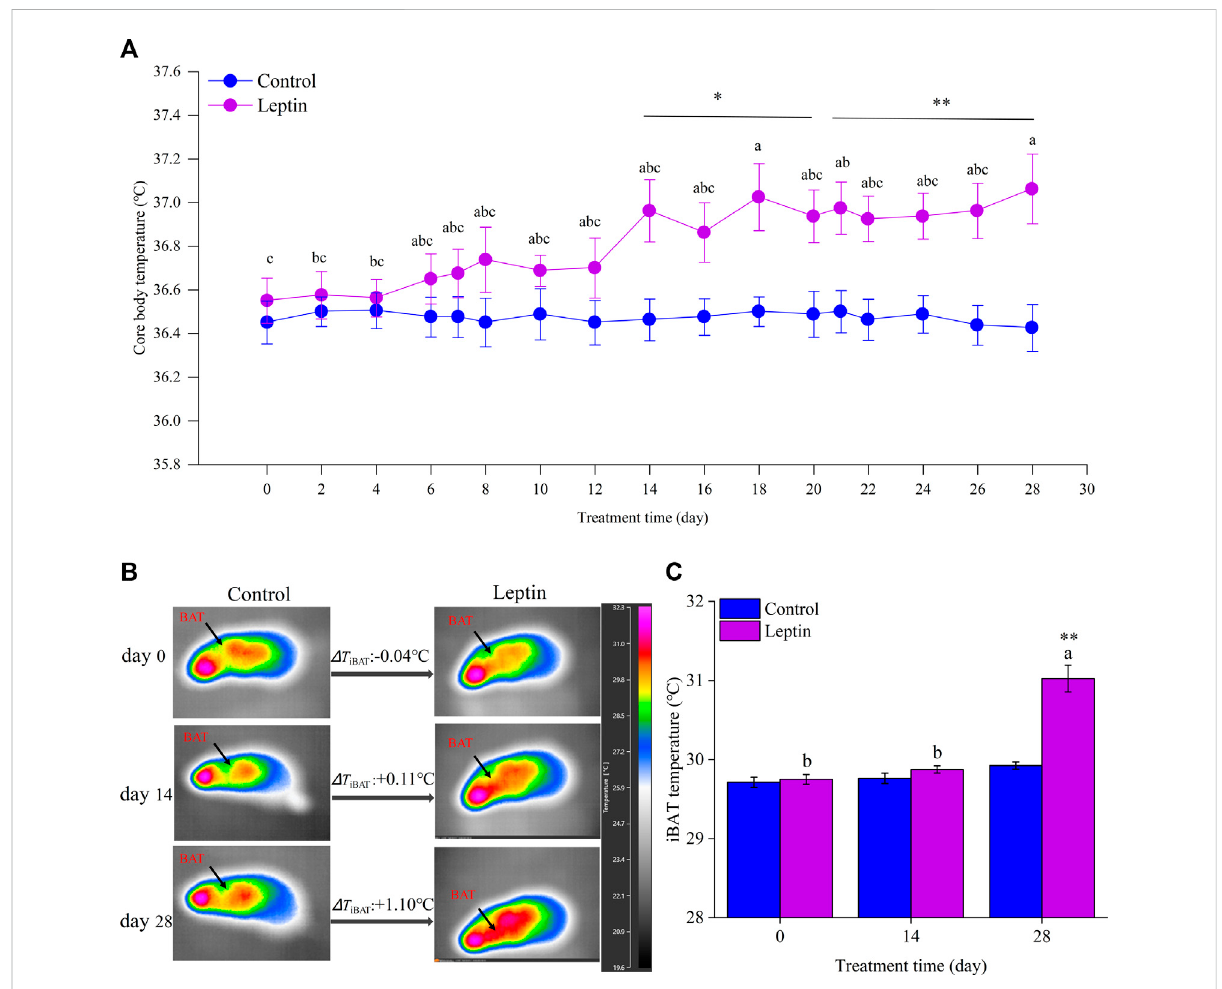
FIGURE 1 Effect of leptin on core body temperature (A) and interscapular skin temperature (B,C) in Eothenomys miletus. Different letters (a – c) indicate signi fi cant differences within the leptin group ( p < .05); *: p < .05, **: p < .01 indicates a signi fi cant difference between the leptin and control groups.